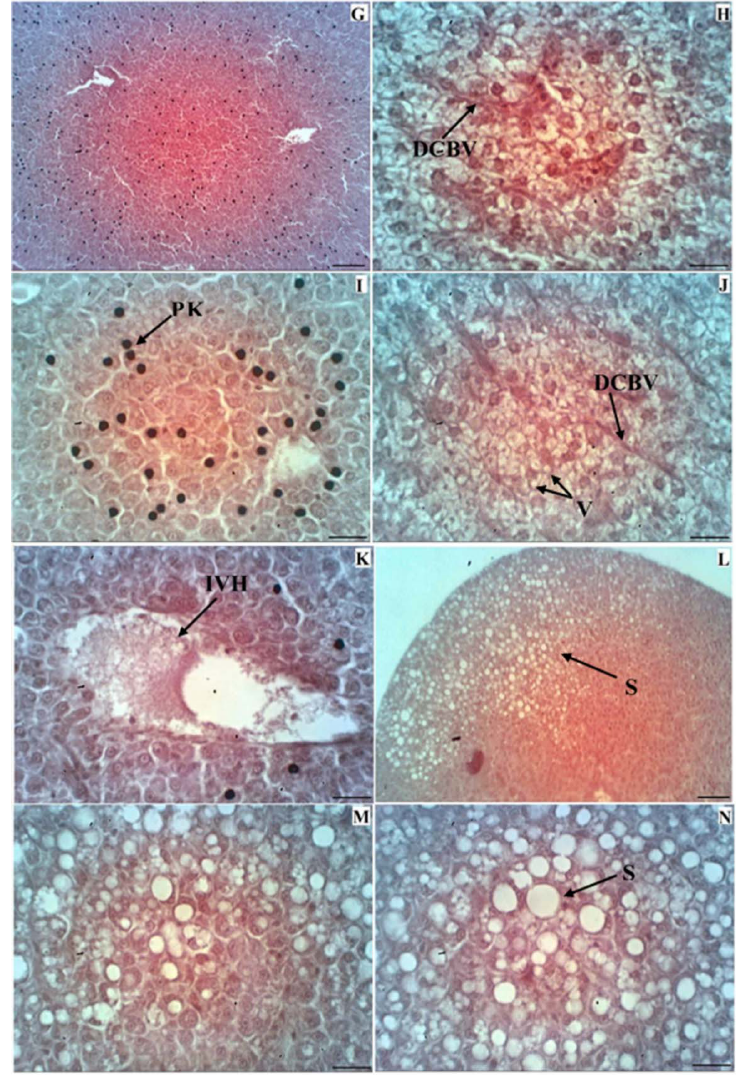
Fig. 3: Transverse section showing histopathology of liver on fipronil exposures in the second week of sampling. G (×725), H (×2900), I (×2900) Dilation and congestion in blood sinusoids (DCBV) in the 65 mg/kg group. J (×2900), K (×2900), L (×725), M (×2900) Intravascular haemolysis in blood vessels (IVH) and steatosis (S) in the 130 mg/kg group. N (×2900) Extensive steatosis (S) in the 200 mg/kg group. H&E, scale bar: 0.05 mm (G and L) and 0.02 mm (H, I, J, K, M, N).